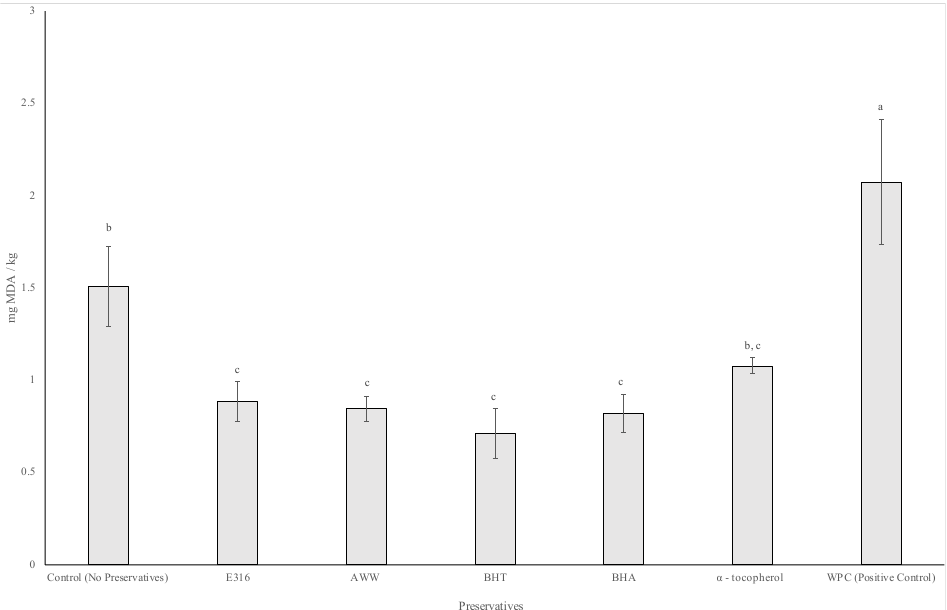
Figure 4. Thiobarbaturic acid reactive substances (TBARS) values (mg MDA / kg) in cooked pork fat containing various synthetic and commercially available additives and spray dried AWW powder. Superscript letters that are the same indicate that mean values do not di ff er statistically when using the Tukey’s test ( p < 0.05). The analysis of each sample was conducted in triplicate. Error bars represent the standard deviation of means. AWW powder used was spray dried at 160 ◦ C at a flow rate of 5.8 g / min and encapsulated with 5%